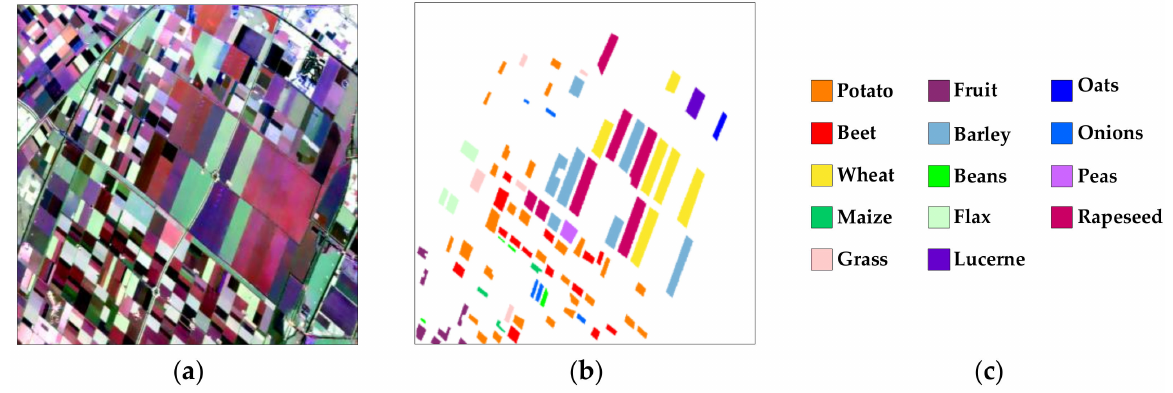
Figure 5. ( a ) Pauli-RGB image of dataset 2, ( b ) ground-truth [17] and ( c ) legend. Dataset 3, acquired by the GaoFen-3 system in 2018, is a C-band PolSAR image of a region in San Francisco, USA, with the image size of 2000 × 2000 pixels. Its Pauli-RGB image, ground-truth map and legend are shown in Figure 6a–c, respectively. It has five labeled terrain classes, including water, vegetation, high-density urban, low-density urban and inclined urban areas. The total number of labeled pixels is